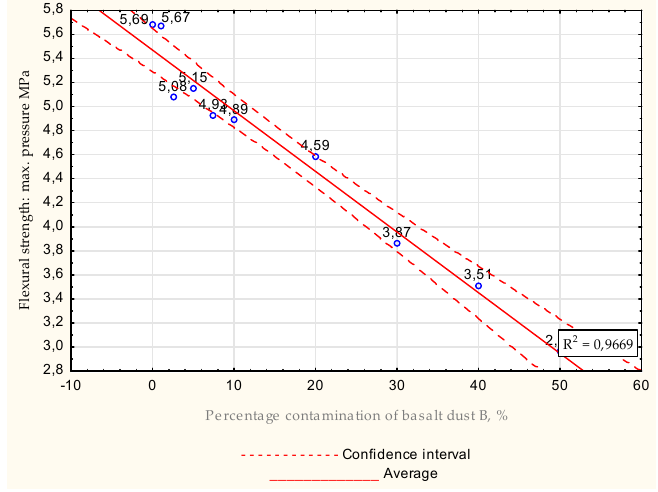
Figure 35. Average values obtained during flexural strength tests after 28 days for water − mix ratio = 0.7, maximal strength.